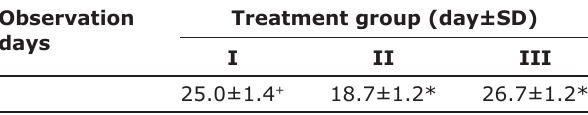
Table-5: Observation of subjective hair growth.